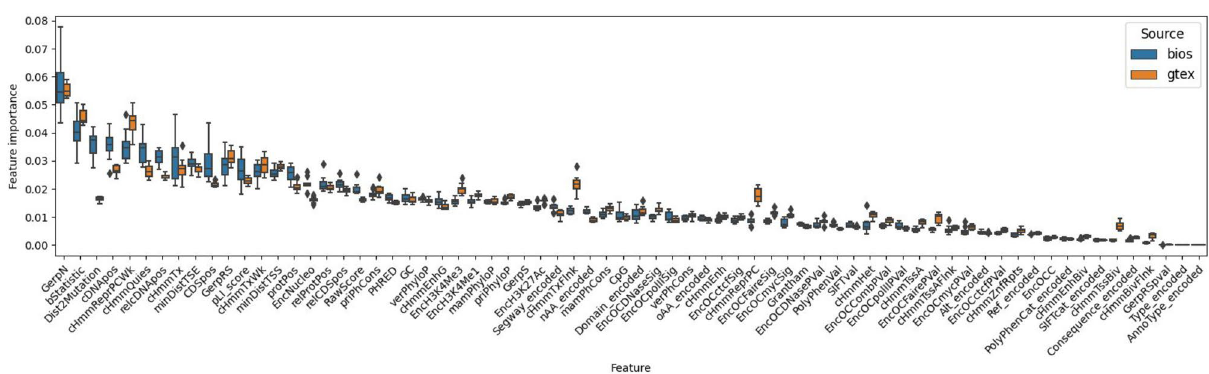
Figure 3. Feature importance of BIOS and GTEx models. The boxes indicate the relative importance of the used features for BIOS (blue) and GTEx (orange). The whiskers indicate quartile variance according to the tenfold training. The features on the X-axis are sorted most to least important based on BIOS, with GTEx importance added for comparison. Plot was produced by Matplotlib 68 version 3.0.0 under Python 69 version